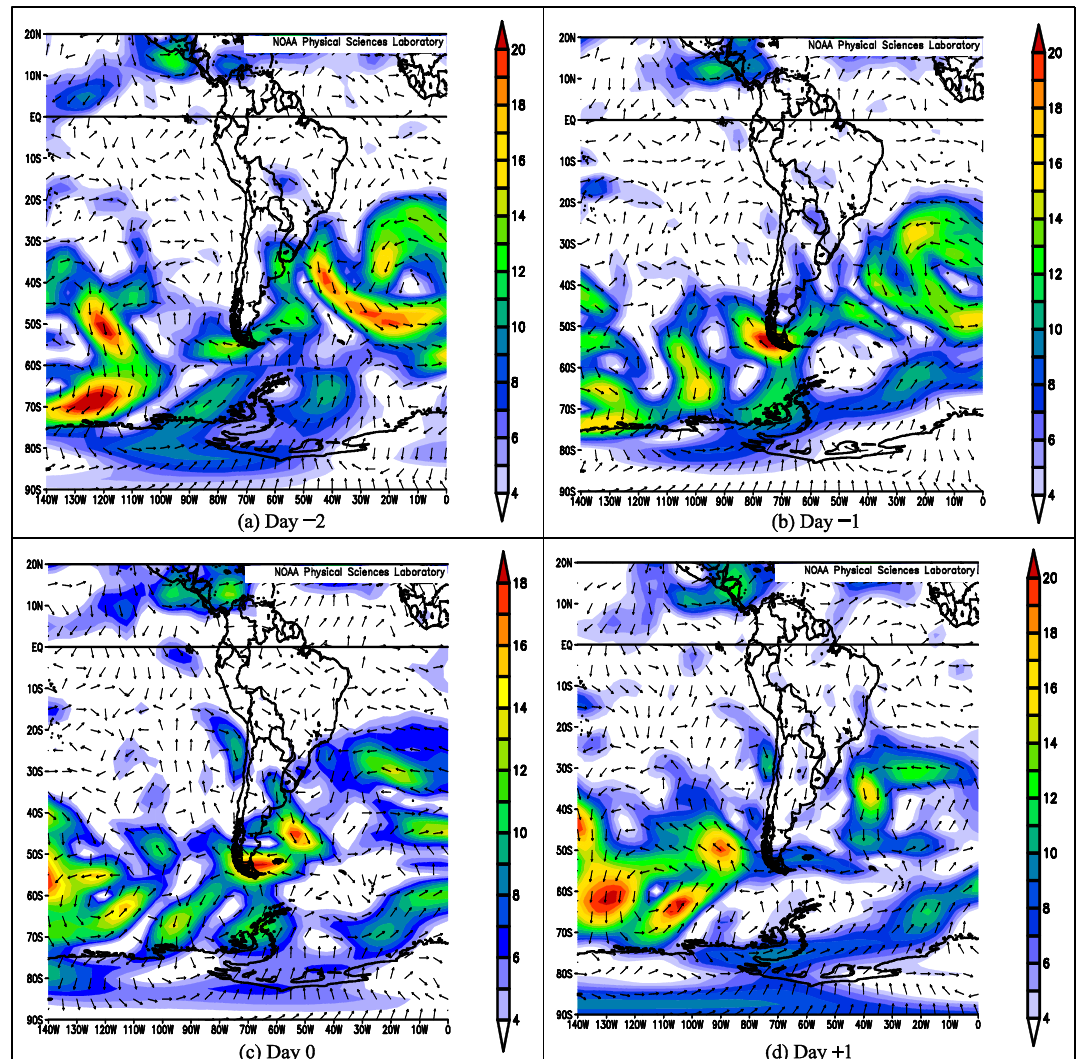
Figure 15. Wind composite anomaly (m/s) at near the surface of the atmosphere (925 hPa) for ( a ) day −2, ( b ) day −1, ( c ) day 0, and ( d ) day +1 of the rainfall event on 15 January 1970. Source: NOAA/ESRL Physical Sciences Laboratory. The climatology base period is